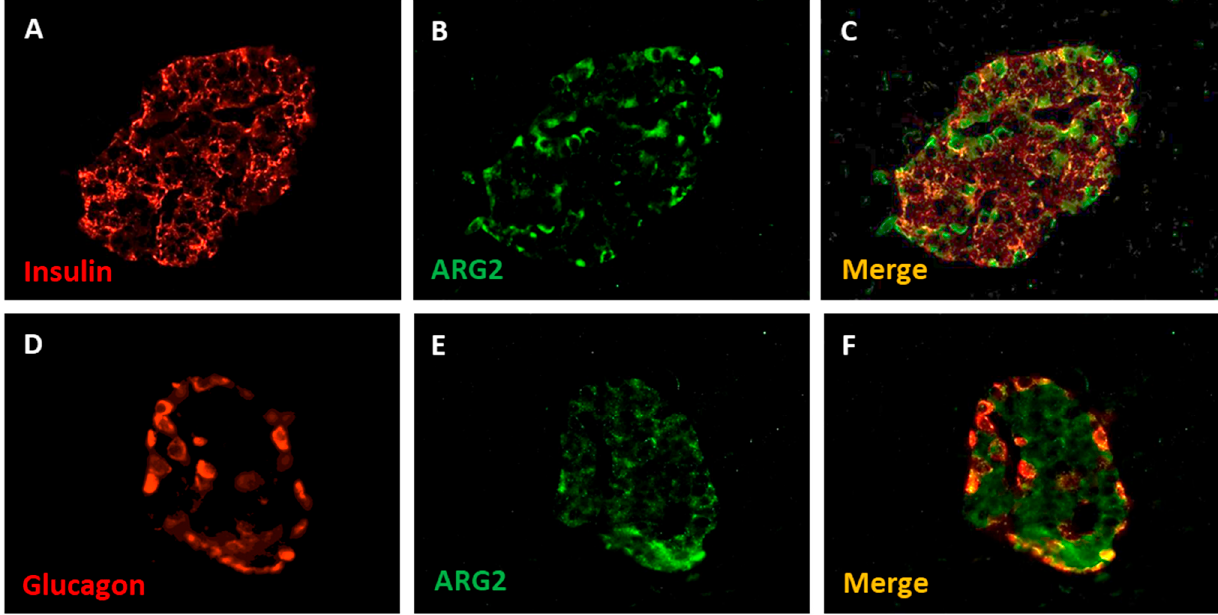
Figure 2. Expression of ARG2 in human tissues. ( A ) Histogram of the Consensus Normalized eXpression (NX) of ARG2 transcript in human tissues as reported in the Human Protein Atlas v20.1 (https://www.proteinat- las.org/ENSG00000081181-ARG2/tissue; accessed on 31 August 2021). Color-coding is based on tissue groups, each con- sisting of tissues with functional features in common. ( B ) Histogram of ARG2 protein expression as reported in Proteomics DB v3.0 (https://www.proteomicsdb.org/; accessed on 31 August 2021) [16,17]. Organ and tissues with the higher protein expression are thyroid and prostate glands, pancreatic islets, kidney, and pancreas. iBAQ: intensity Based Absolute Quantification.